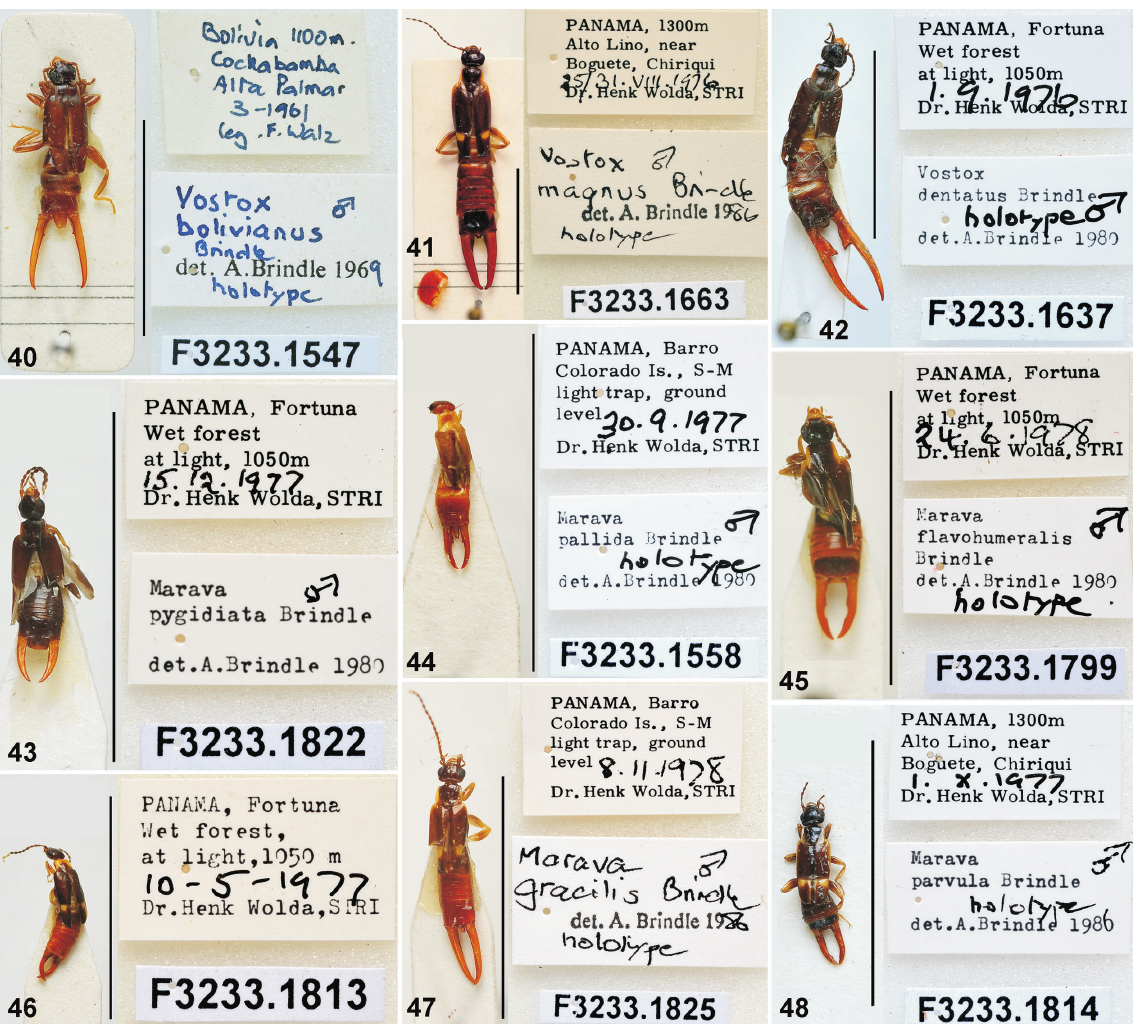
Figs 40–48. Holotypes (♂) of Spongiphoridae from the collection of the Manchester